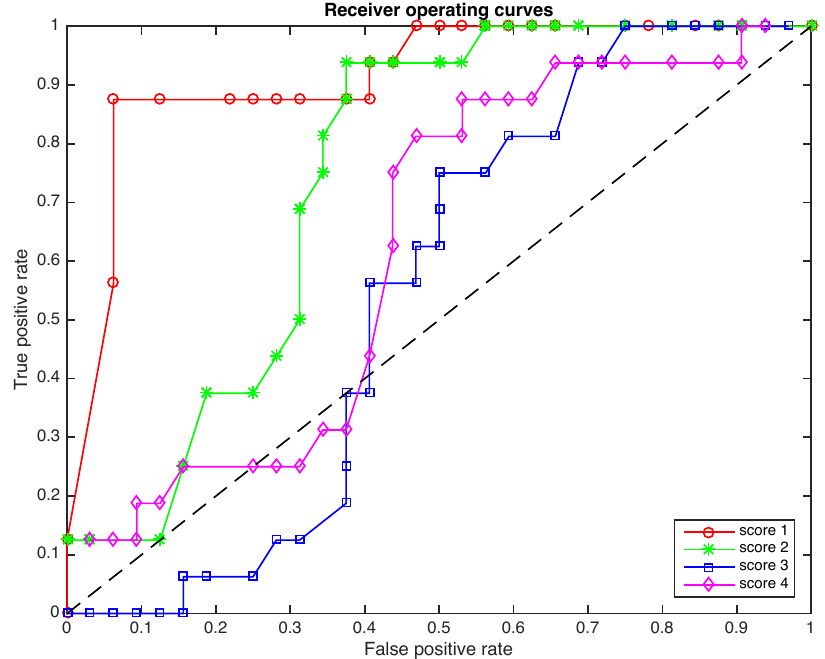
Figure 8. The ROCs for the four scores when the size of the samples to diagnose is ν =